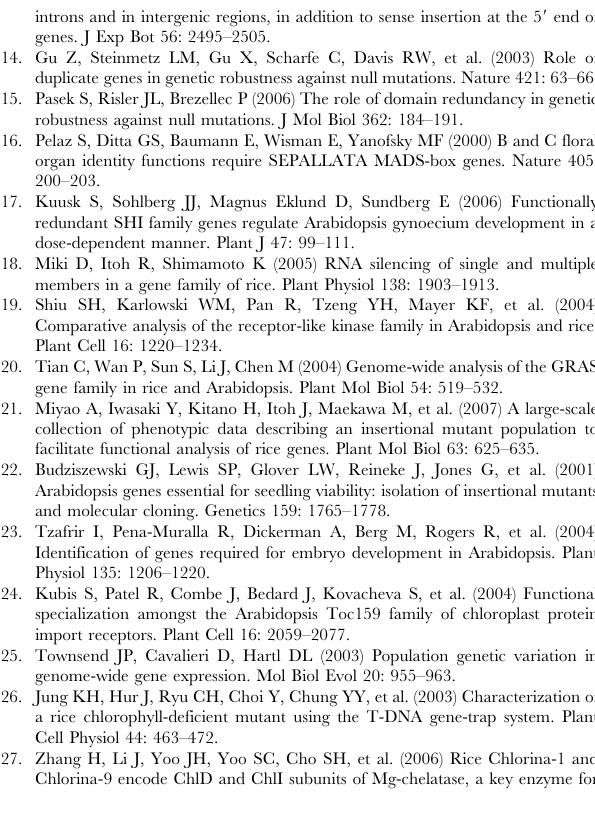
Table S3 Summary of Screen for Phenotypes Associated with 17 Candidate Genes Which Were Not the Predominantly Expressed Gene Family Members in the Light or Did Not Show Consistent Gene Expression Patterns among the Microarray Datasets.